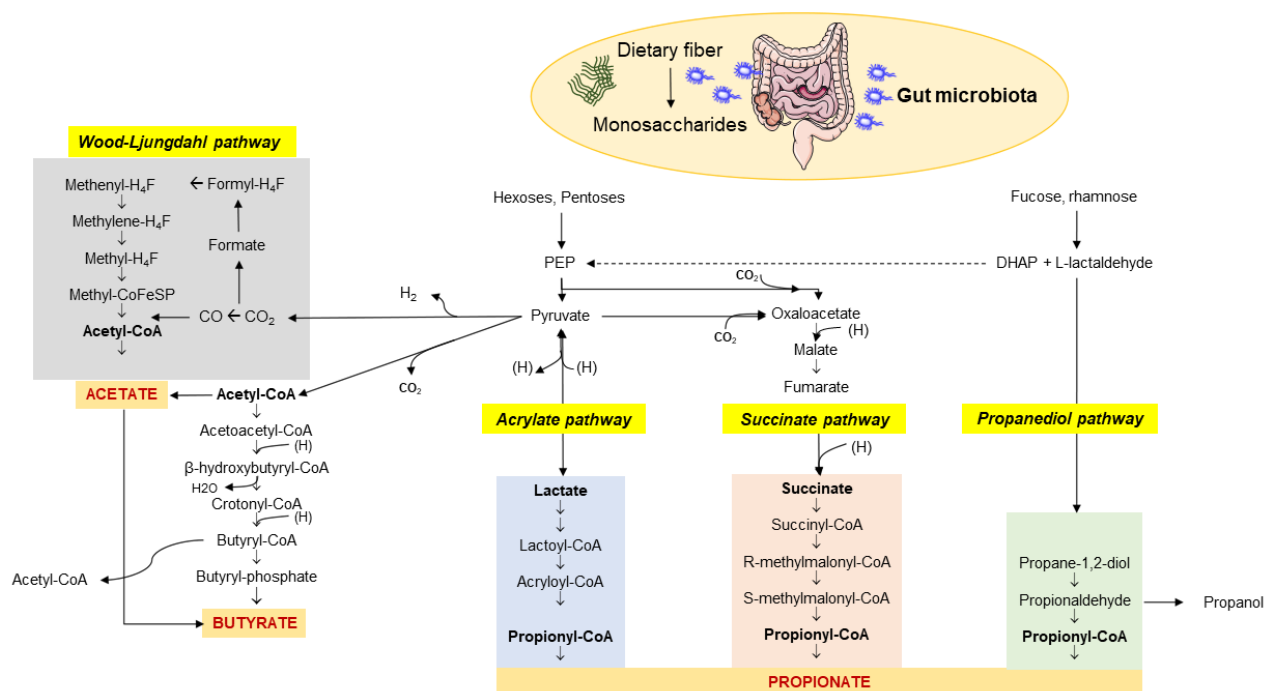
Figure 1. Pathways involved in the biosynthesis of SCFAs from dietary fiber and carbohydrate fermentation by the colonic microbiota. The three major SCFAs are: (1) acetate which originates via